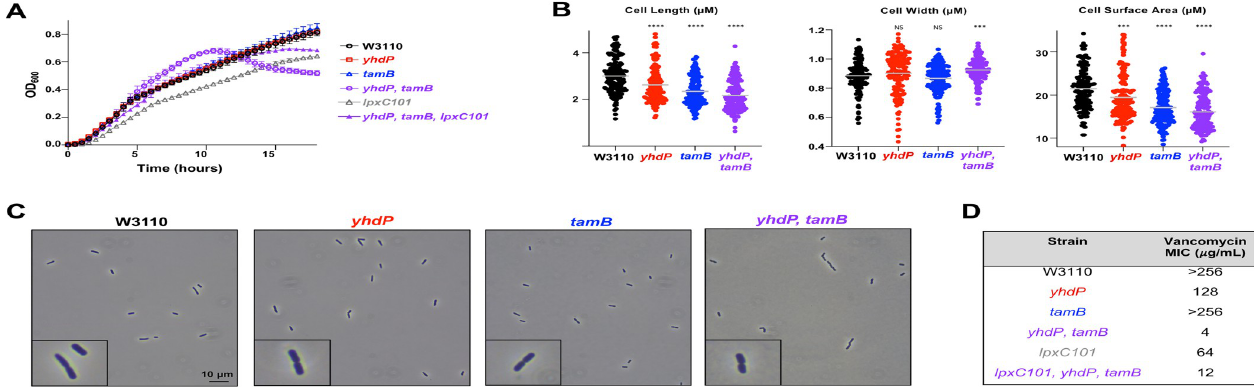
Fig 4. yhdP , tamB mutants in W3110 exhibit multiple defects associated with the cell envelope. (A) Growth of yhdP , tamB mutants. Strains were monitored by OD 600 every 30 minutes at 37˚C and error bars represent SD from technical triplicates with data representative of 3 biological replicates. (B) Loss of both yhdP and tamB results in decreased cell surface area. Cell width and length of listed strains were measured using MicrobeJ software after strains were grown to mid-log phase and imaged at 1000x on agarose pads, cell surface area was calculated using cell width and length. Grey bar indicates mean. T-test used between strains. 0.0001 > P ���� , 0.001 > P ��� . (C) Microscopy of yhdP and tamB mutants. Phase contrast microscopy (1000x) of the indicated cells with black scale bar set to 10 μ m. Image in bottom left corner of dividing cell is a 300x zoom of the larger image. Microscopy data is representative of two biological experiments. (D) The vancomycin MIC of yhdP , tamB mutants and respective control strains. MICs were determined by E-test after overnight growth at